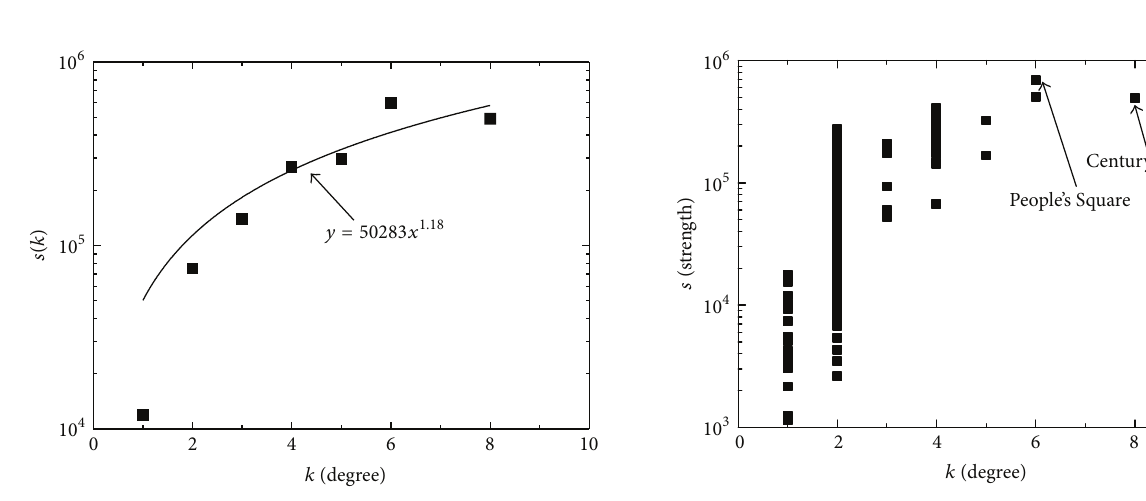
Figure 1: Degree and strength distributions for the RTS networks.